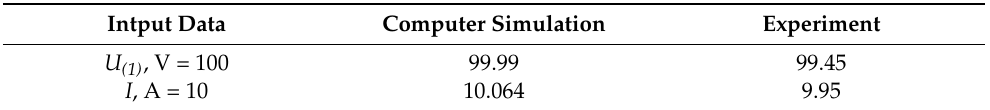
Table 4. Values of quantities obtained from the design of a voltage source inverter and the results of computer simulations and experiment.